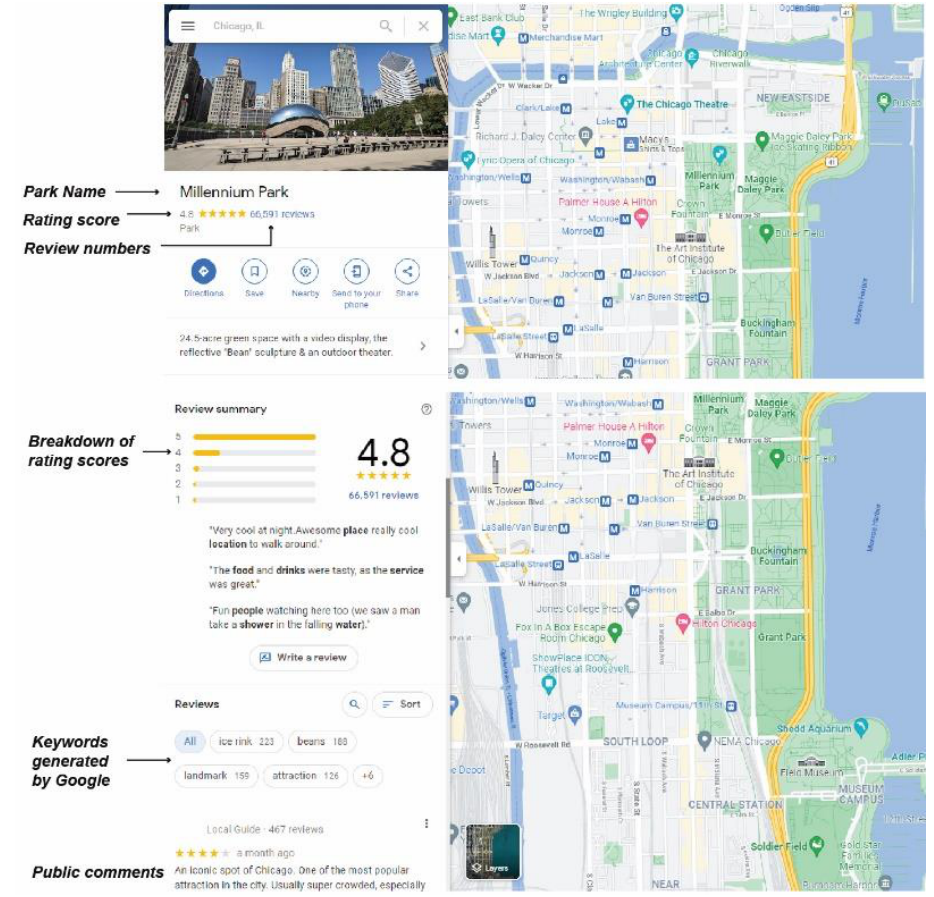
Figure 2. Google Map Reviews interface example.